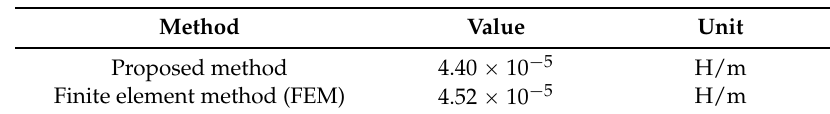
Table 2. Permeability of bridge.